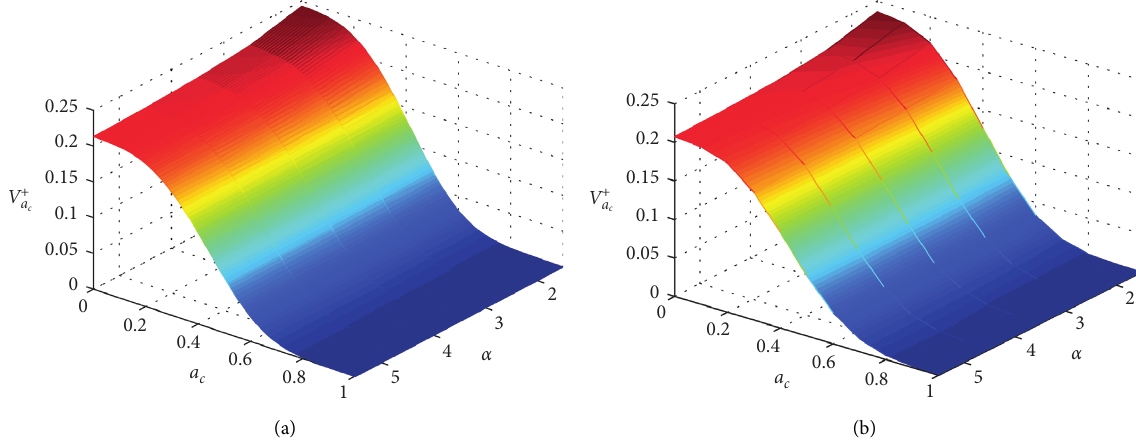
a c and fractional order α (